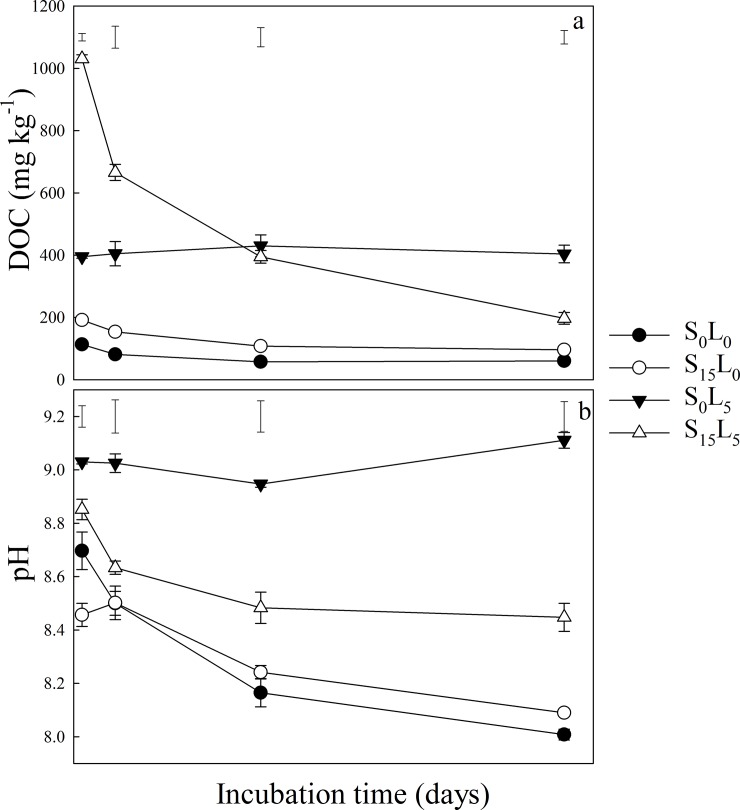
CO2-C emission rate (a) and cumulative CO2-C emission (b) during straw decomposition under different treatments. (S0W0L0, only soil; S0W12L0, only wood ash; S0W0L5, only lime; S0W12L5, wood ash plus lime; S15W0L0, only wheat straw; S15W12L0, wheat straw plus wood ash; S15W0L5, wheat straw plus lime; S15W12L5, wheat straw and wood ash plus lime.). The error bars outside the curve represent LSD.